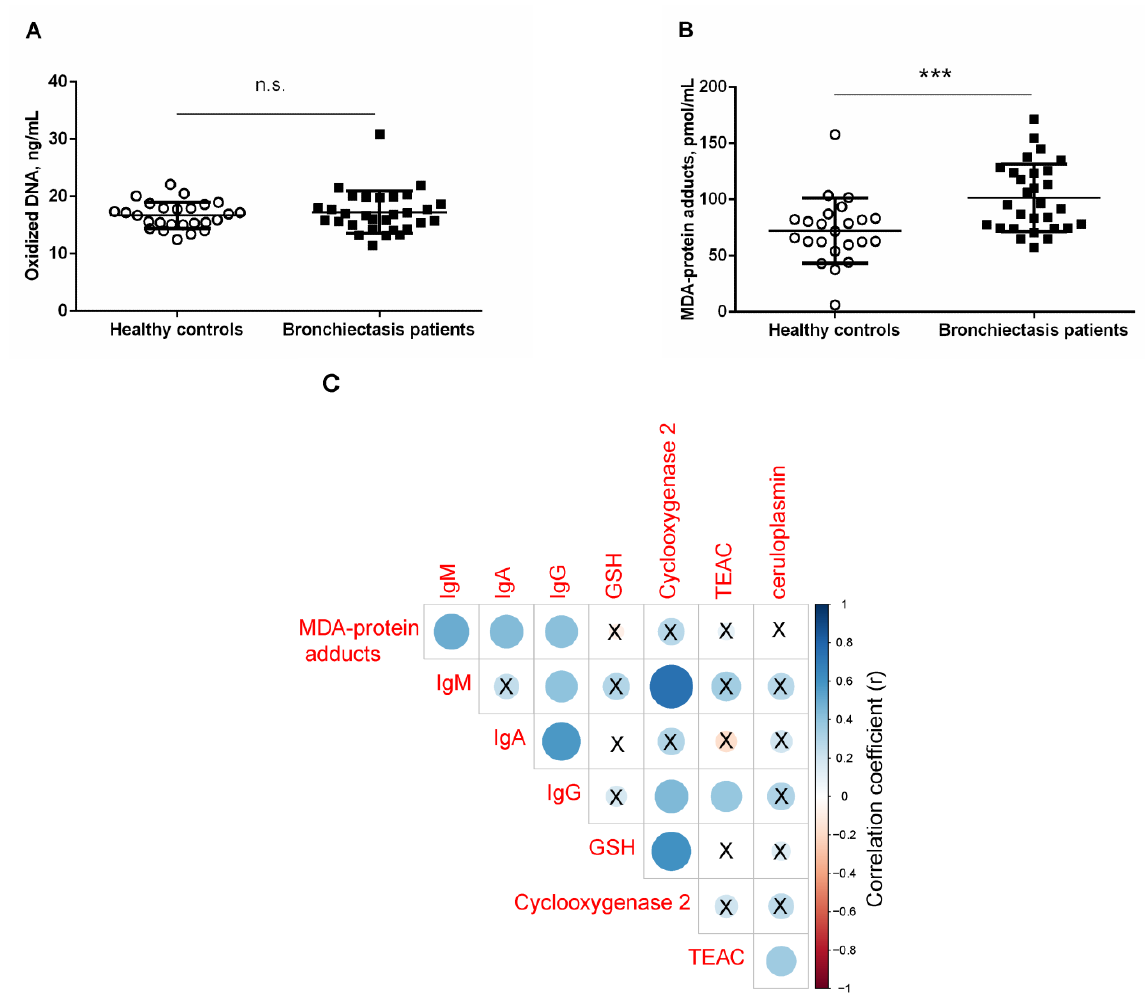
Figure 3. Mean values and standard deviations of plasma ( A ) oxidized DNA levels (ng/mL) and ( B ) MDA–protein adducts (pmol/mL) in healthy controls and bronchiectasis patients. Statistical significance: *** p ≤ 0.001 between bronchiectasis patients and healthy controls; and n.s., non-significant differences between the two study groups. ( C ) Correlation matrix of the disease among different biological and analytical variables, in which positive correlations are represented in blue, while negative correlations are represented in red. The intersection within the circle represents p value > 0.05. Color intensity and the size of the circle are proportional to the correlation coefficients, as indicated in the Y axis on the right-hand side of the graph.